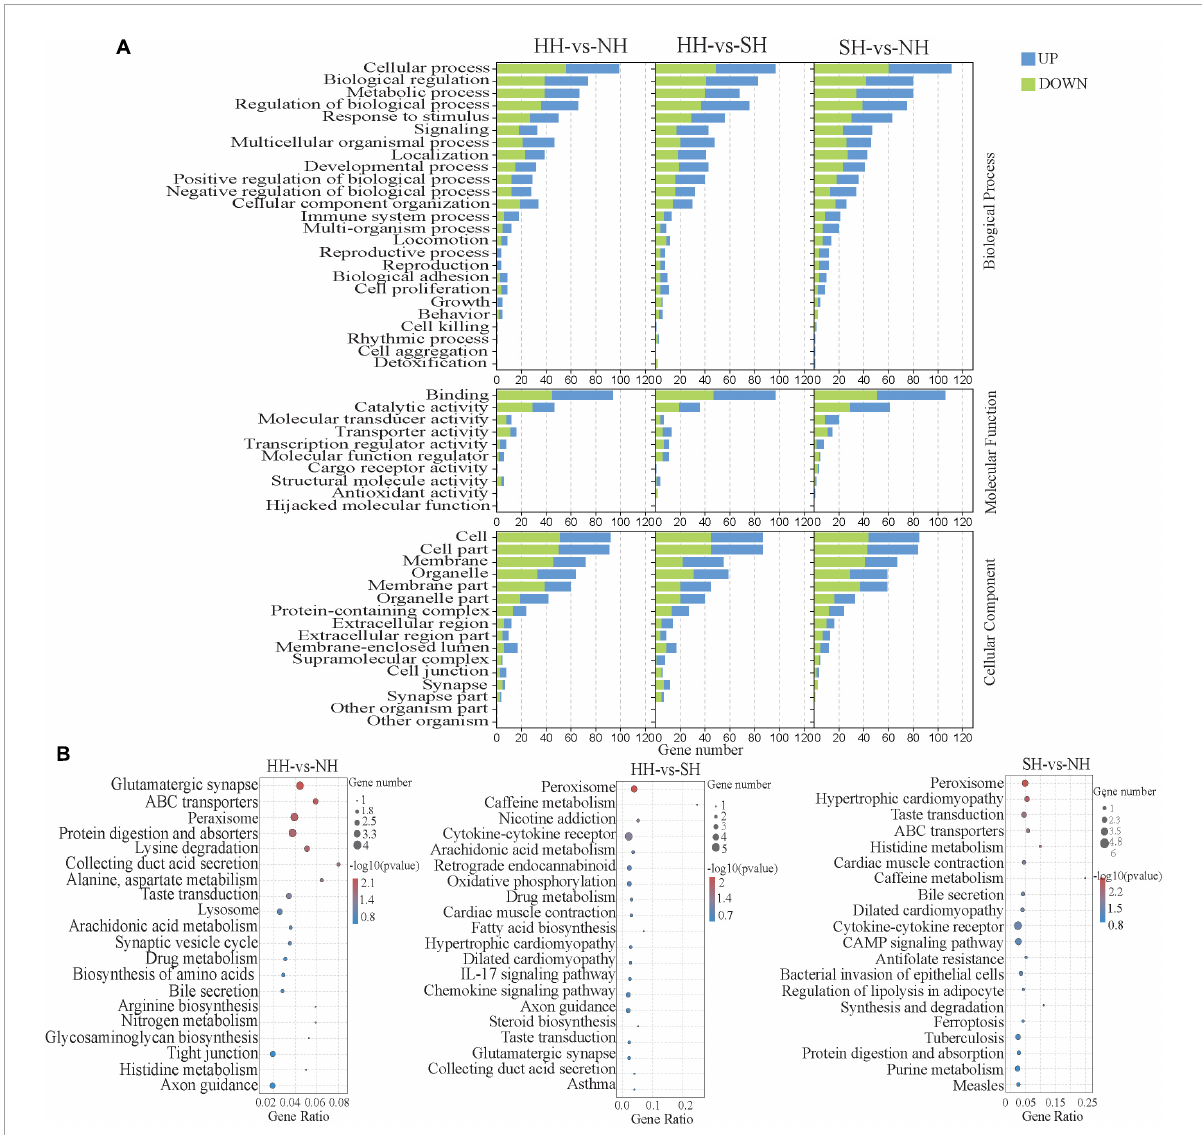
FIGURE2 Functional enrichment analysis of the longissimus dorsi samples of the HH, SH an NH sheep. (A) GO analysis of the DEGs in the three groups. The ordinate indicates the GO terms. (B) Bubble diagram of the top 20 KEGG pathway enrichments for the HH-NH, HH-SH, and SH-NH comparisons. The ordinate indicates the